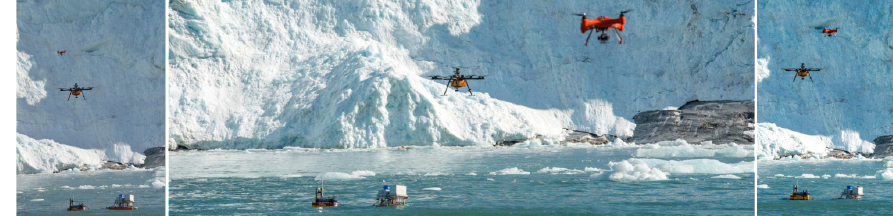
Figure 17. PROTEUS, OTTO and Splash unmanned vehicles operating near the Blomstrandbreen glacier.